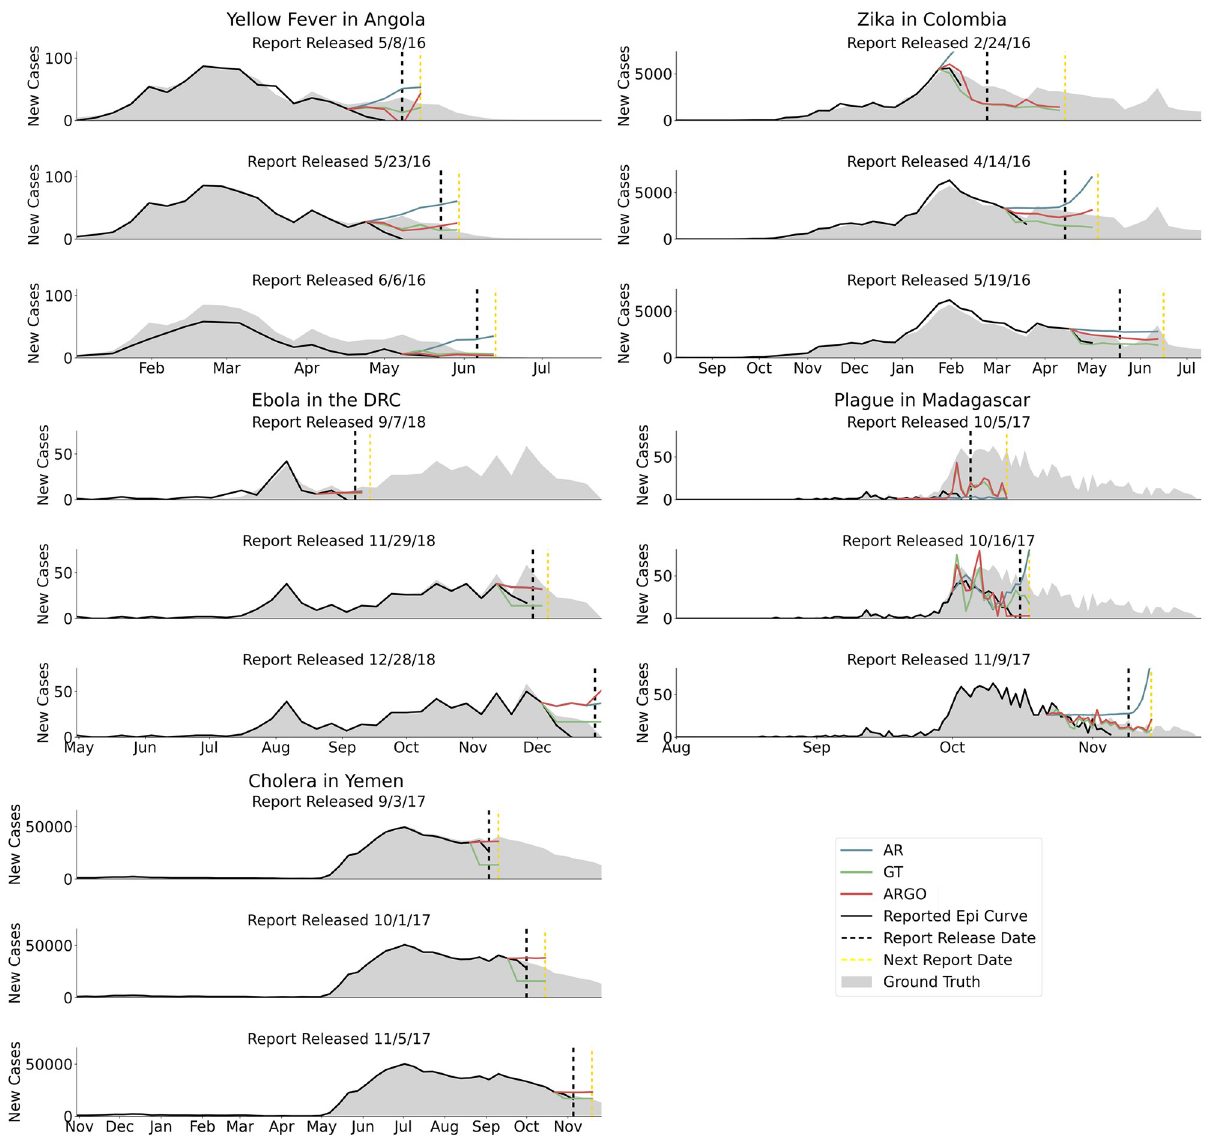
Fig 4. Summary of evaluation approach based on publicly released reports. In each figure, the grey filled area is the ground truth data (available at, or after, the end of the outbreak). The black line shows surveillance data released in each report at the time of publication (the date of publication is denoted by the dashed black line), and the colored lines show the real-time predictions of our three models. Here, figures are included for three epidemiological situation reports for each outbreak; more plots with the same evaluation task can be found in S6–S10 Figs. For inclusion in this figure, we chose three evenly-spaced situation reports from the middle of each